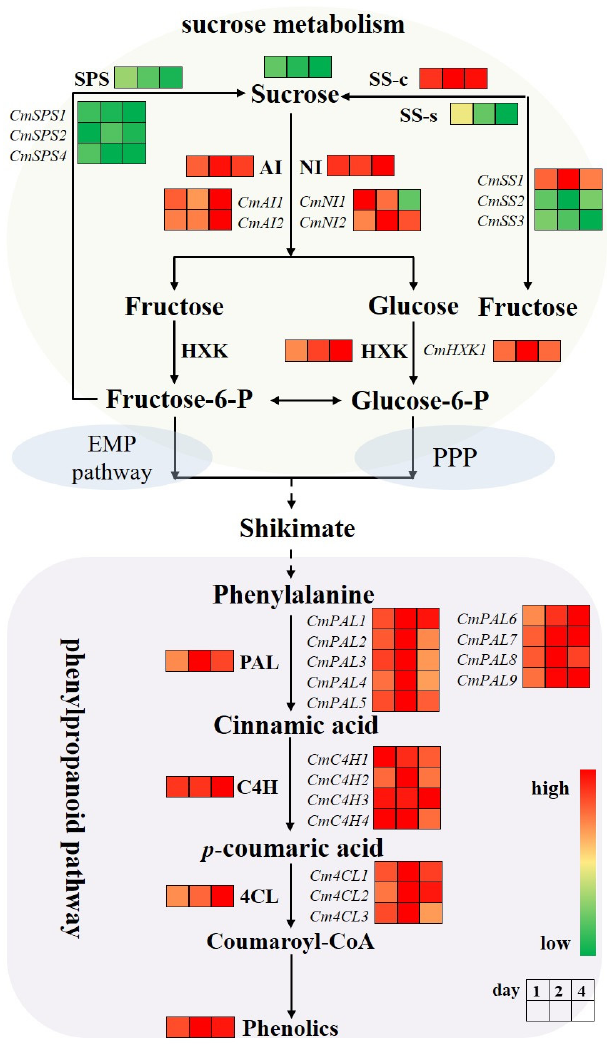
Figure 7. A hypothetical model to explain how cut-wounding promoted the conversion of sugars to supply necessary substrates for phenolic accumulation in melon fruit during storage at 15 °C. Red and green respectively represent the significant increase and decrease in metabolite content, enzyme activity and gene expression, while yellow means no significant difference ( p < 0.05). All the significant differences are compared with whole melon fruit.